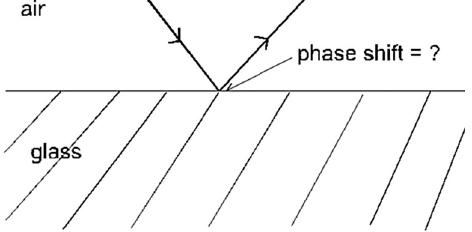
FIG. 4. Reflection of light at an air-glass